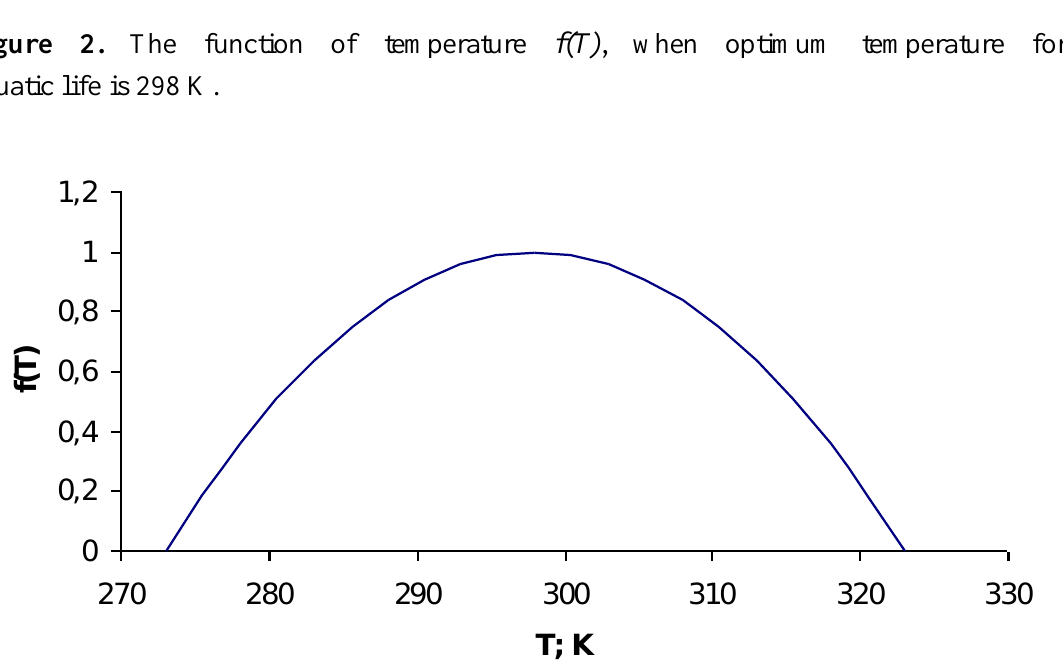
Figure 2. The function of temperature f(T) , when optimum temperature for aquatic life is 298